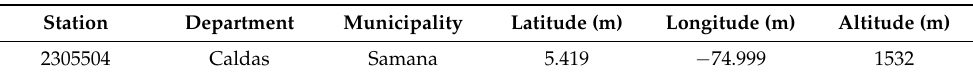
Table 5. Information of the region that contributes the most to the first component. Source: author’s processing.